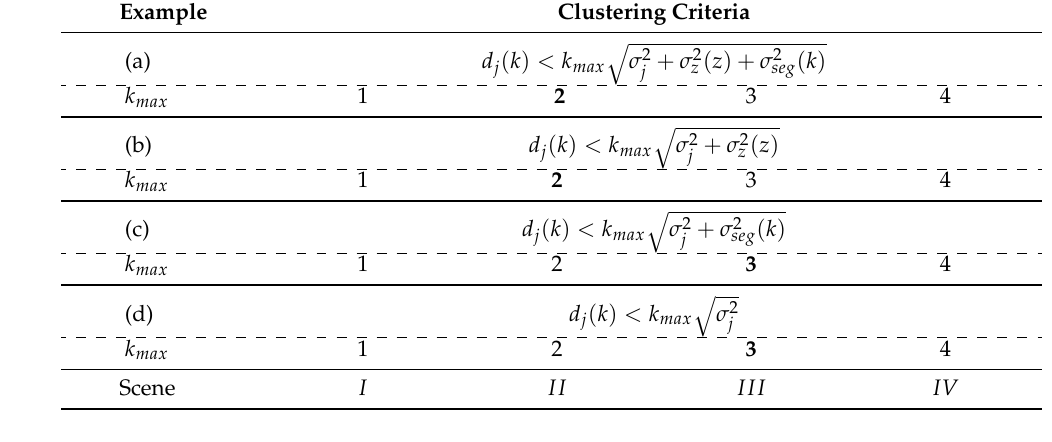
Table 2. Values of k max in the tuning process for different forms of clustering criteria. Bold numbers represent optimal values, where we achieve the lowest over-segmentation (see also Figure 20). Example